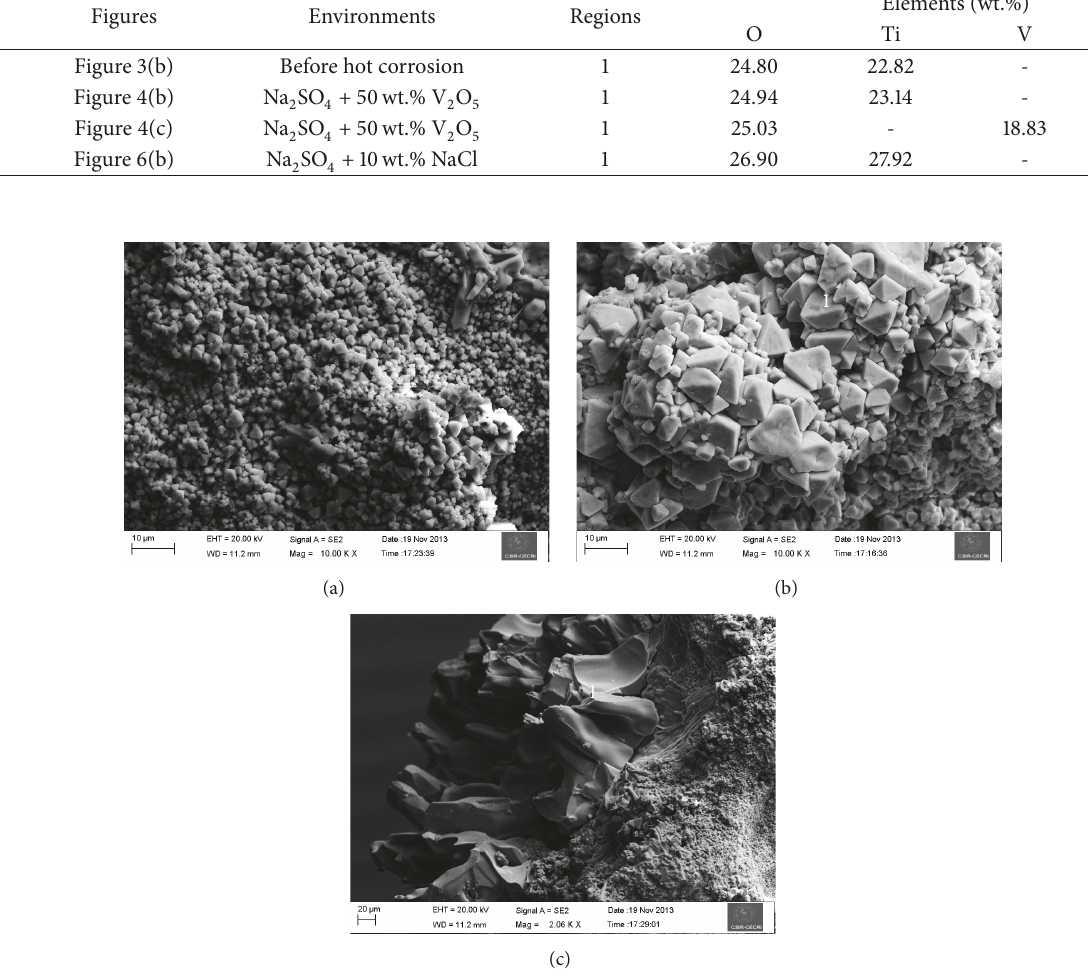
Figure 4: Surface morphology of SrTiO 3 after being subjected to hot corrosion in Na 2 SO 4 + 50 wt.% V 2 O 5 environment at 900 ∘ C, (a and b) lower and higher magnification images of SrTiO 3 , shows octahedron shaped morphology. EDX analysis was demonstrated on (b) at region 1 (corresponding to strontium titanate); (c) higher magnification image at other regions of (a) shows irregular shape morphology. EDX analysis was done on (c) at region 1 (corresponding to strontium